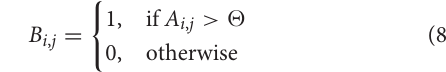
number publications jointly mentioning gene i and gene j .